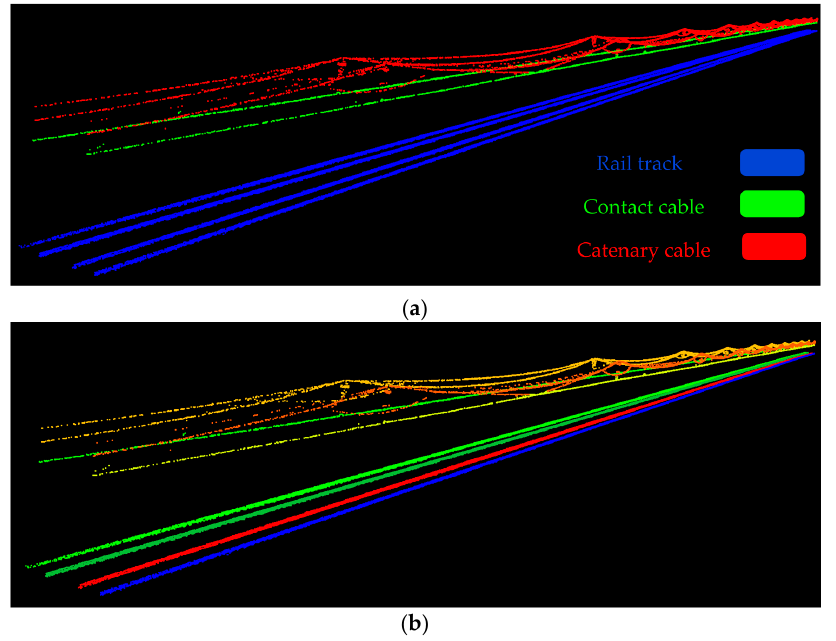
Figure 15. Results: ( a ) The classification results based on the object type; ( b ) The classification results in which all objects are separately recognized and demonstrated in a different color, regardless of their type.